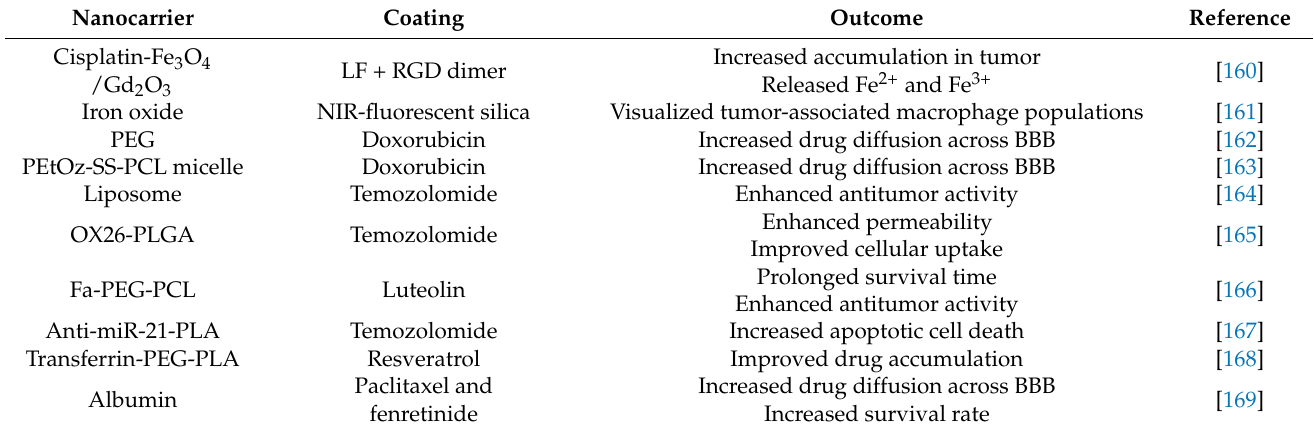
Table 2. Various NP-based drug delivery systems for the potential treatment of